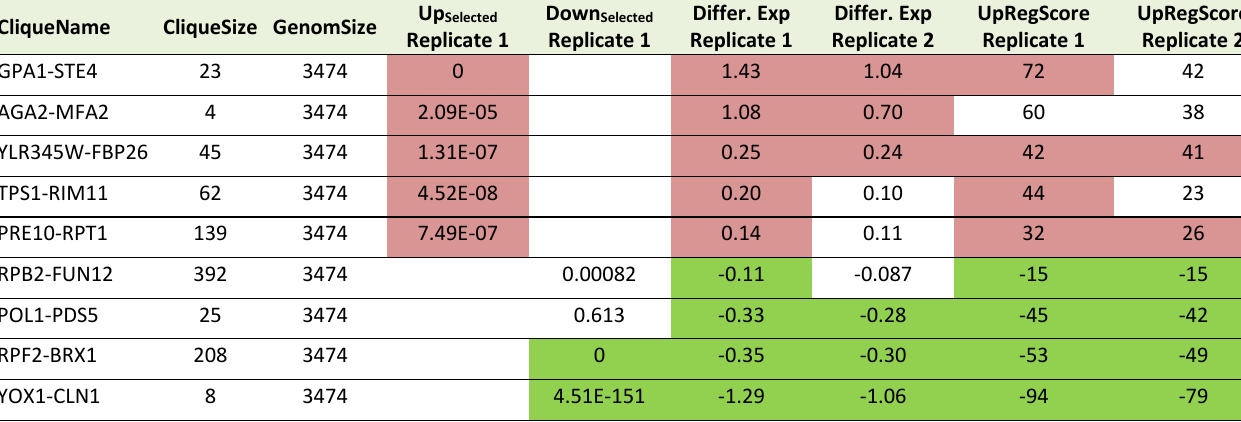
TABLE 3. Most prominent hits from differential expression after pheromone induction within the 72 expression cliques for replicate 1 and replicate